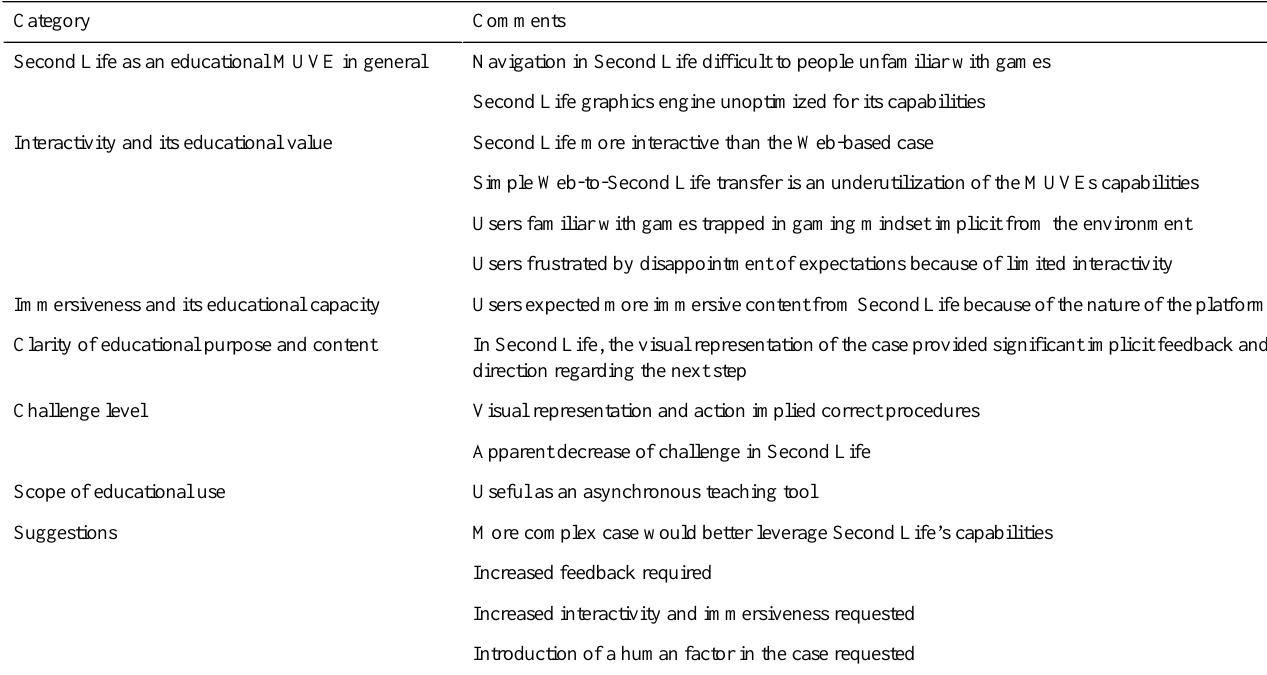
Table 2. -Focus group’s results at-a-glance.